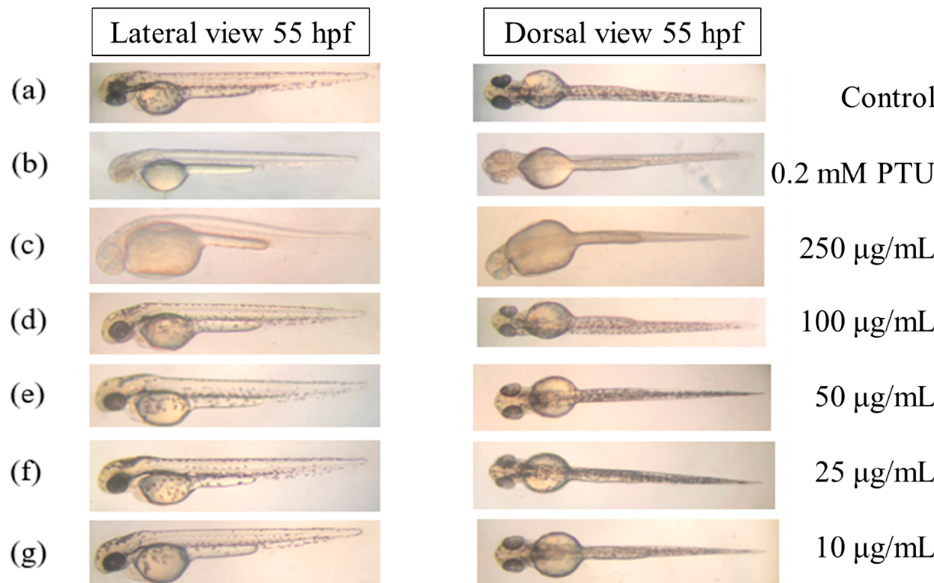
Figure 4. Depigmenting effect of ethanol extracts from fermented-germination black soy milk on melanogenesis in zebrafish embryos in an in vivo phenotype-based system. Representative images of synchronized zebrafish embryos treated with ethanol extracts from fermented-germination black soy milk at 55 hpf (48 h treatment). Depigmentation efficacy of ethanol extracts of fermented-nongermination black soy milk in zebrafish embryos were photographed under stereomicroscope at the same magnification. PTU, phenylthiourea; hpf, h post fertilization. ( a ) Zebrafish embryos without treatment as a control, ( b ) 0.2 mM PTU as a standard positive control, ( c ) 250 µg/mL, ( d ) 100 µg/mL, ( e ) 50 µg/mL, ( f ) 25 µg/mL, and ( g ) 10 µg/mL.